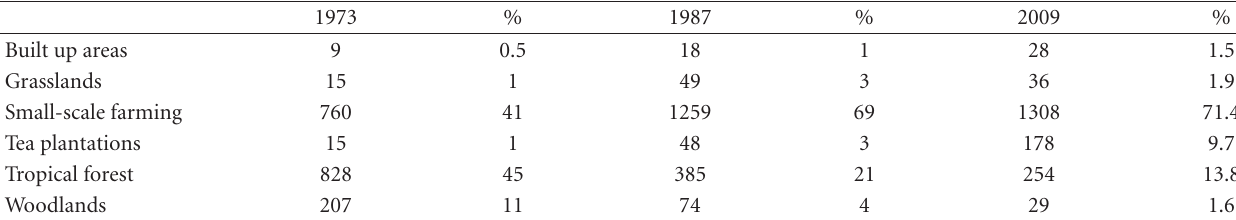
Table 1: showing land use and cover changes.